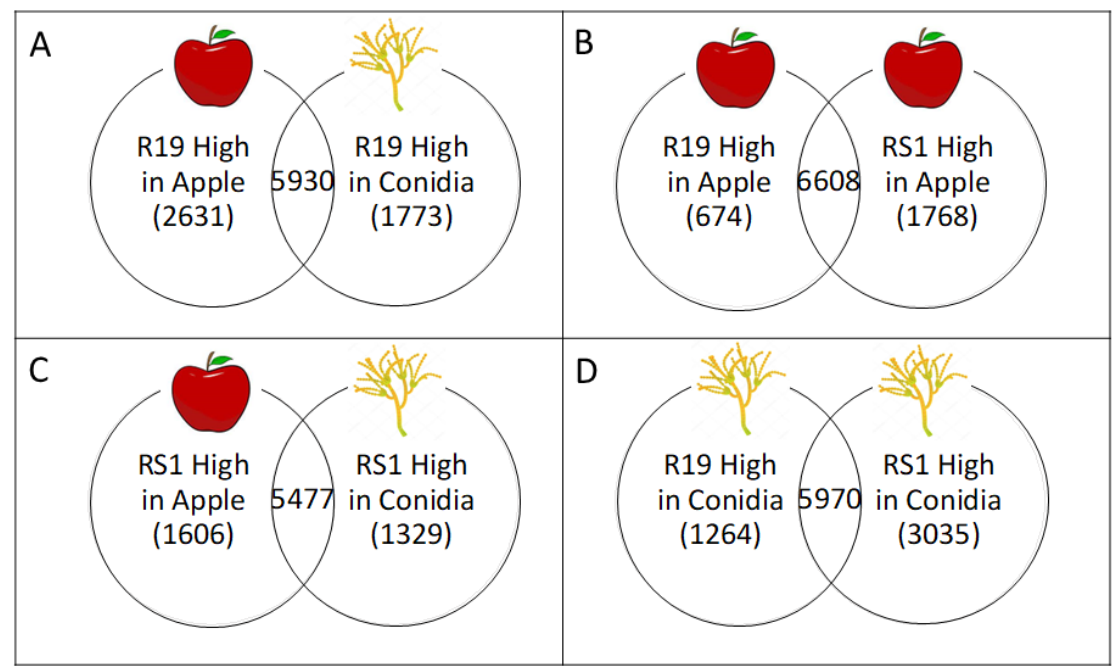
Figure 3. Venn diagram of differentially expressed genes (DEGs) between Penicillium spp. R19 and RS1 in apple and conidia. Comparisons show DEGs higher in each category between ( A ) R19 apple vs. ungerminated conidia, ( B ) Ramifying hyphae and mycelium in apple from R19 and RS1, ( C ) RS1 ramifying hyphae and mycelium in apple vs. ungerminated conidia, and ( D ) ungerminated conidia from R19 and RS1. Numbers represent upregulation (high) expression (log 2 fold change ≥ 2) with p -value < 0.05. Values in overlapping regions are genes that did not have significant differential gene expression between sample types.